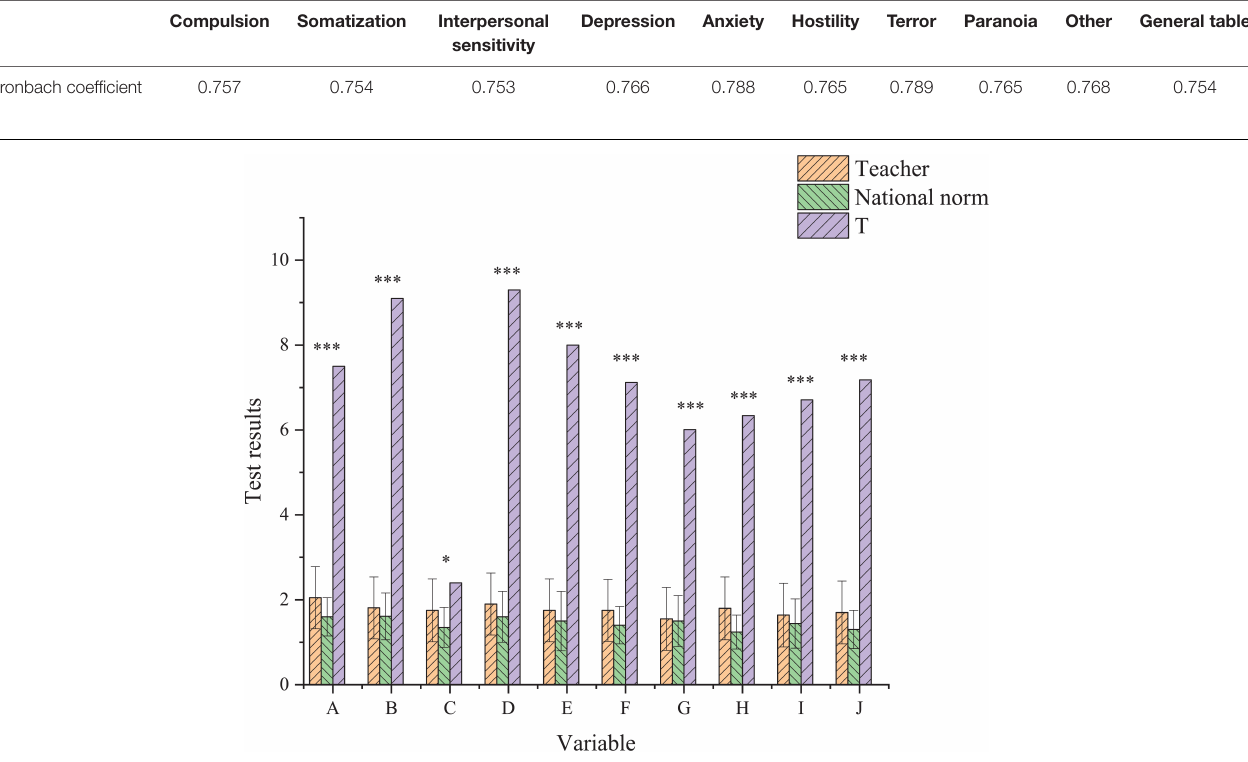
TABLE 3 | Reliability analysis.